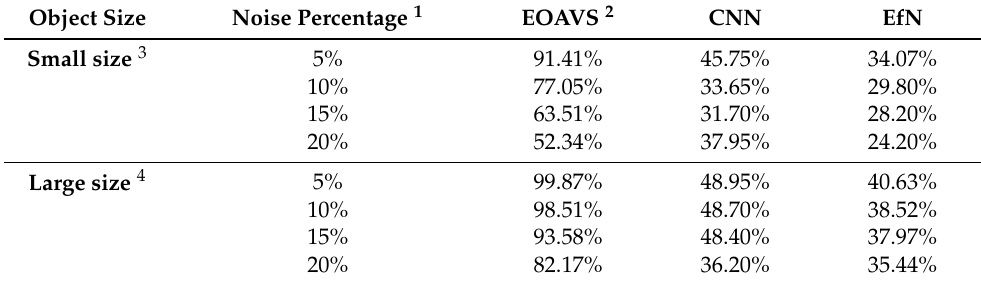
Table 4. Background noise accuracy.